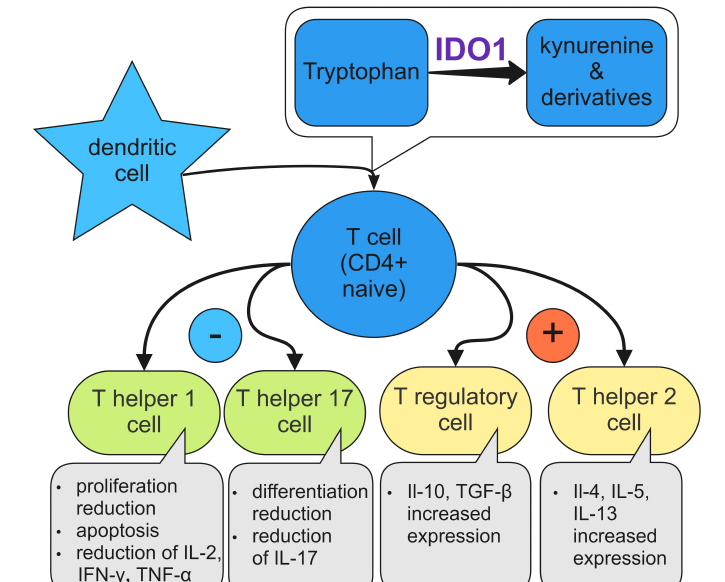
Figure 3. The influence of IDO1 on T